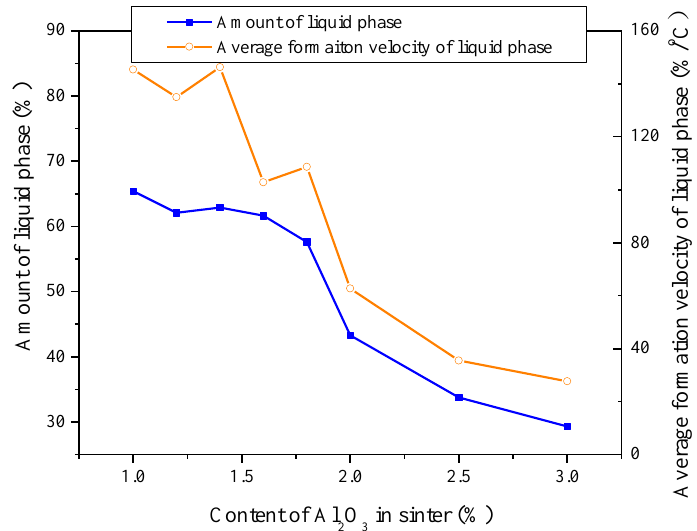
Figure 11. E ff ects of Al 2 O 3 content on the production and formation rate of the liquid Figure 11. Effects of Al 2 O 3 content on the production and formation rate of the liquid phase.